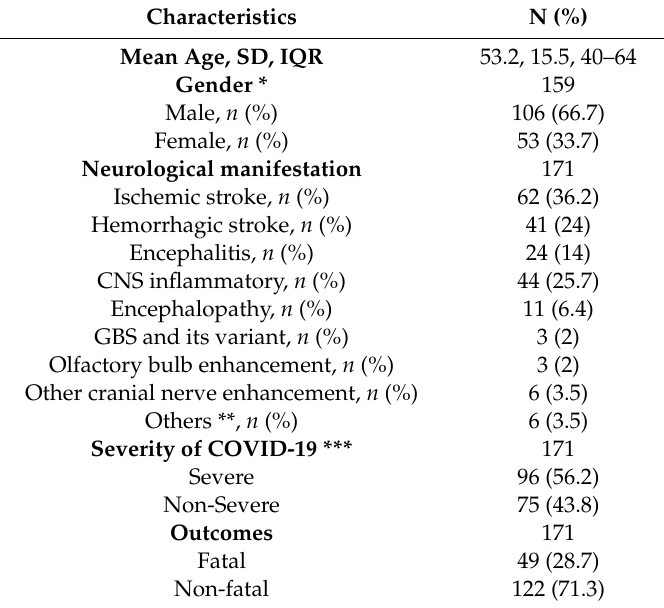
Table 1. General characteristics of COVID-19 ( n = 171) patients with neurological